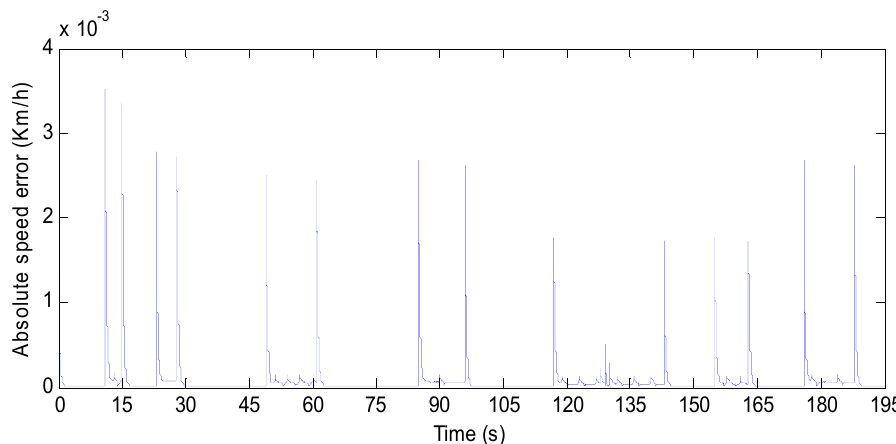
Figure 25. BEV speed response and its reference for ECE driving cycle.